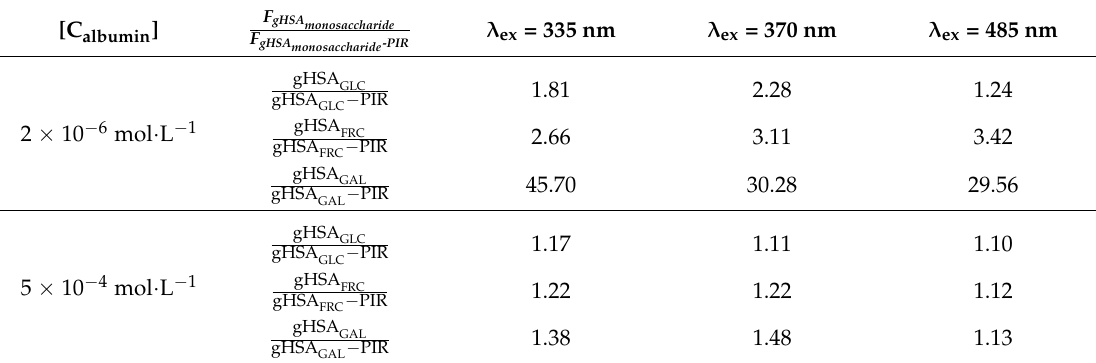
Table 1. The quotient of AGEs fluorescence intensity in gHSA GLC , gHSA FRC , gHSA GAL , gHSA GLC -PIR, gHSA FRC -PIR, gHSA GAL -PIR, [HSA] 2 × 10 − 6 mol · L − 1 and 5 × 10 − 4 mol · L − 1 , λ ex = 335 nm, λ ex = 370 nm, and λ ex = 485